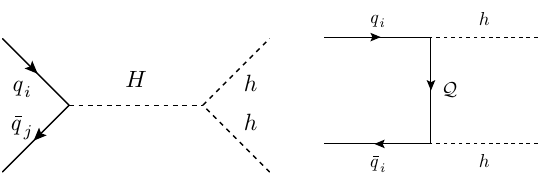
Figure 1 . Examples of potential concrete models leading to a hhqq coupling. The left Feynman diagram shows a heavy Higgs H , the right diagram a vector-like quark Q